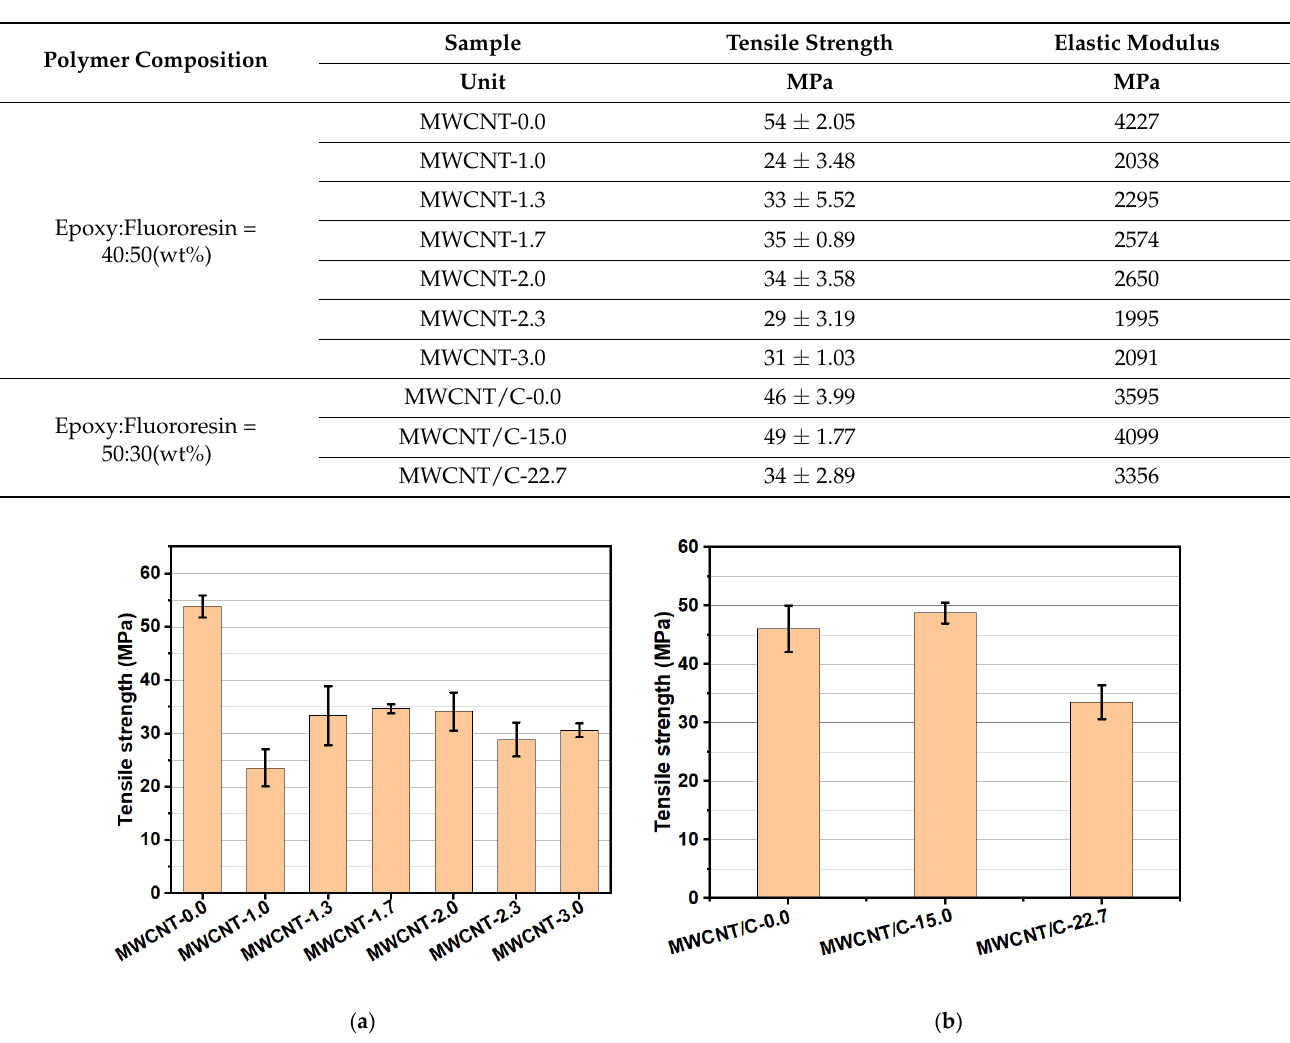
Table 7. Evaluation of mechanical properties according to polymer resin composition and MWCNT content.